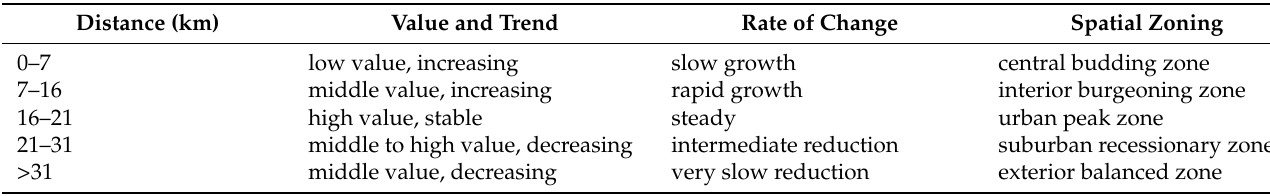
Table 5. Results for the spatial zoning patterns in